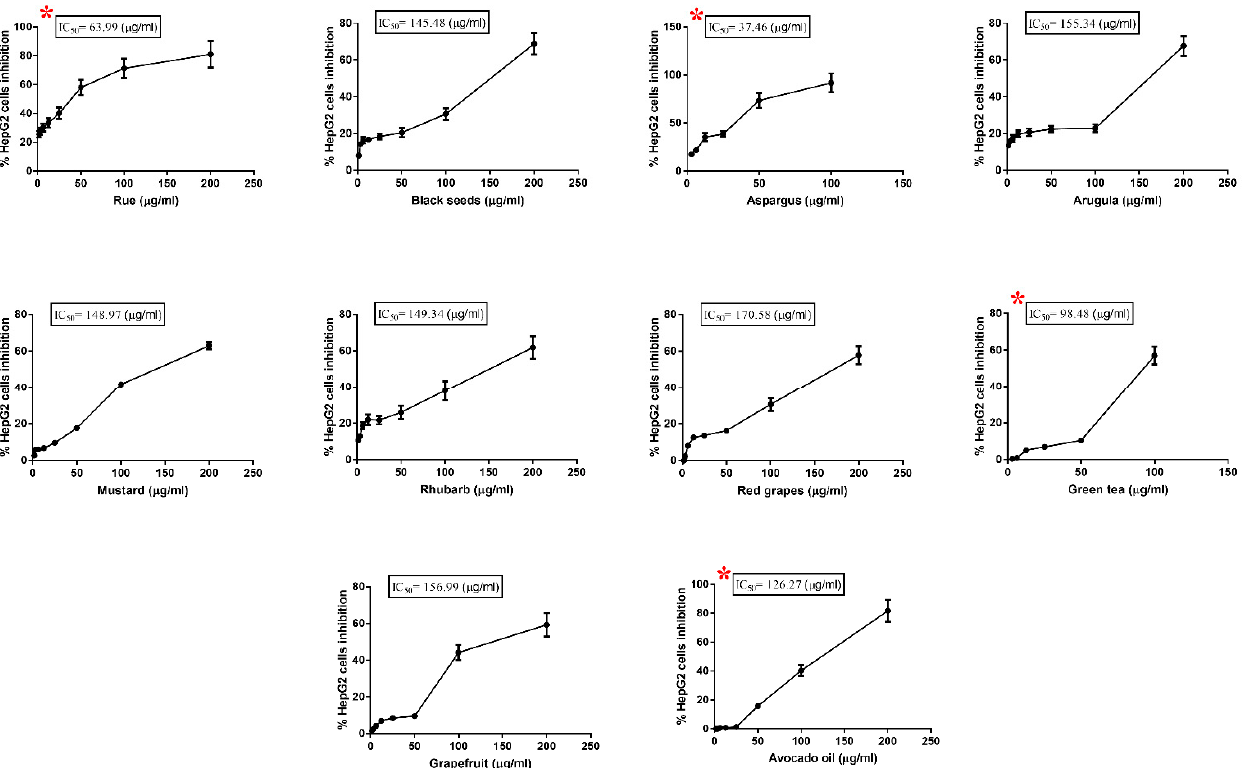
Figure 1. The cytotoxicity of the ten plant extracts on HepG2 cells after treatment for 48 h. Experiments were performed in triplicate. Data are presented as mean ± S.D. * Indicates the plant extract with the lowest IC 50 , which was selected for further investigation. Table 2. Comparison of doxorubicin IC50 using untreated HepG2 cells to the rue-, asparagus-, avocado-, and green tea-pretreated